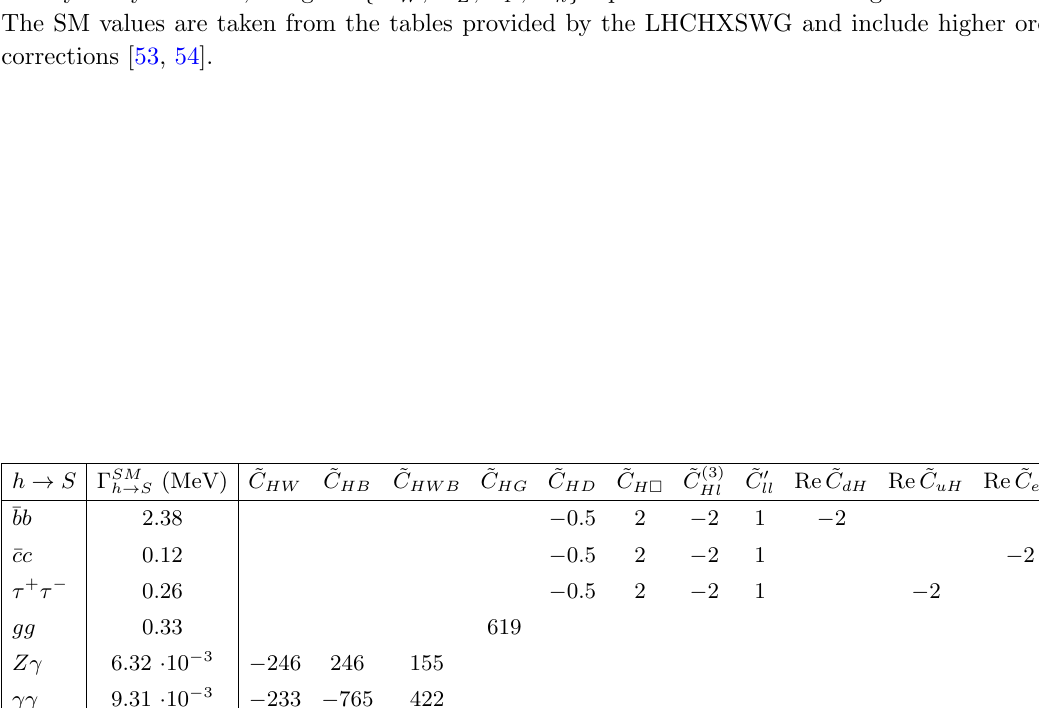
in the relative SMEFT correction for i